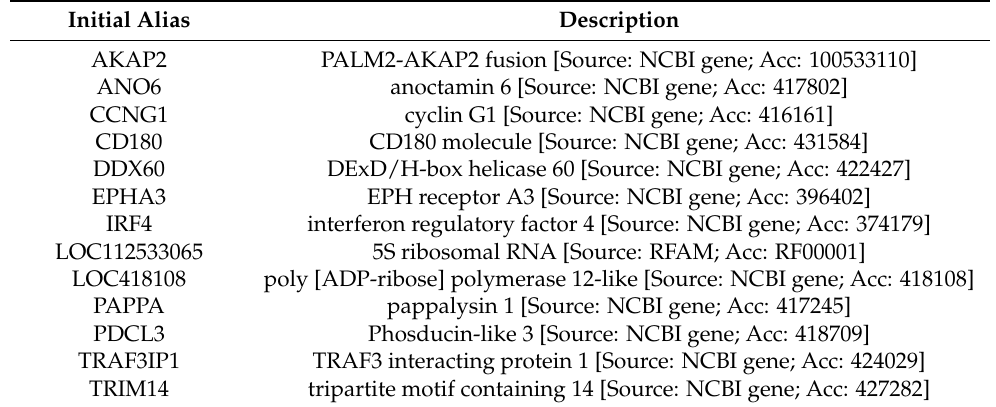
Table 3. Annotated differentially upregulated genes in LB hens.